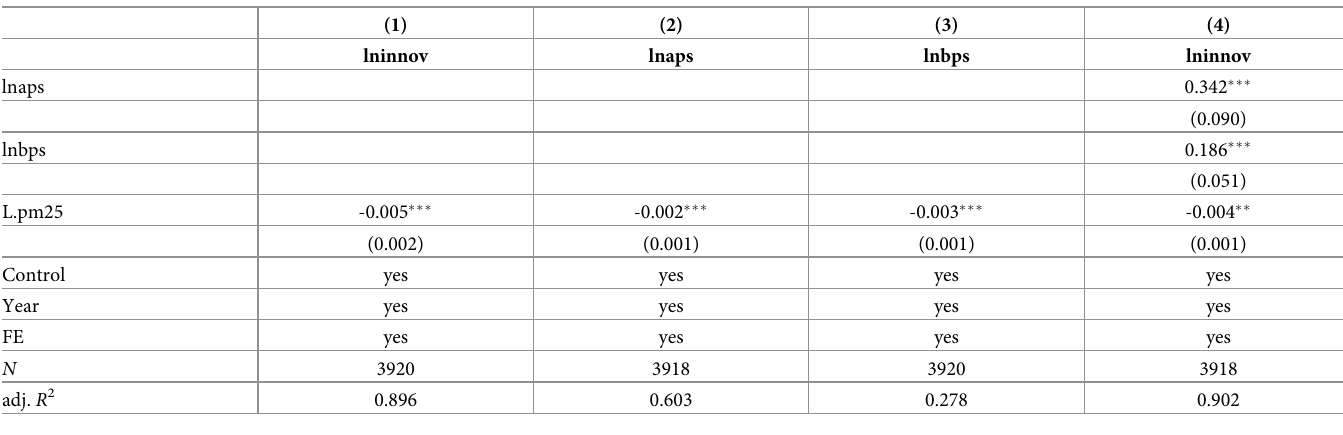
Table 17. Advanced productor services and basic productor